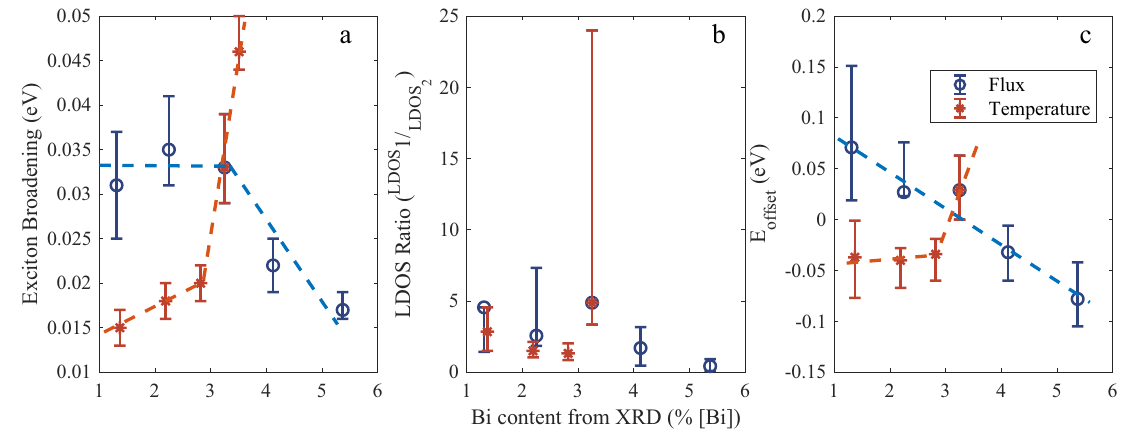
Figure 4. Trends in model parameters ( a ) σ G , ( b ) LDOS ratio and ( c ) E offset versus Bi content from XRD modelling. Blue and orange dashed lines have been added to guide the eye.